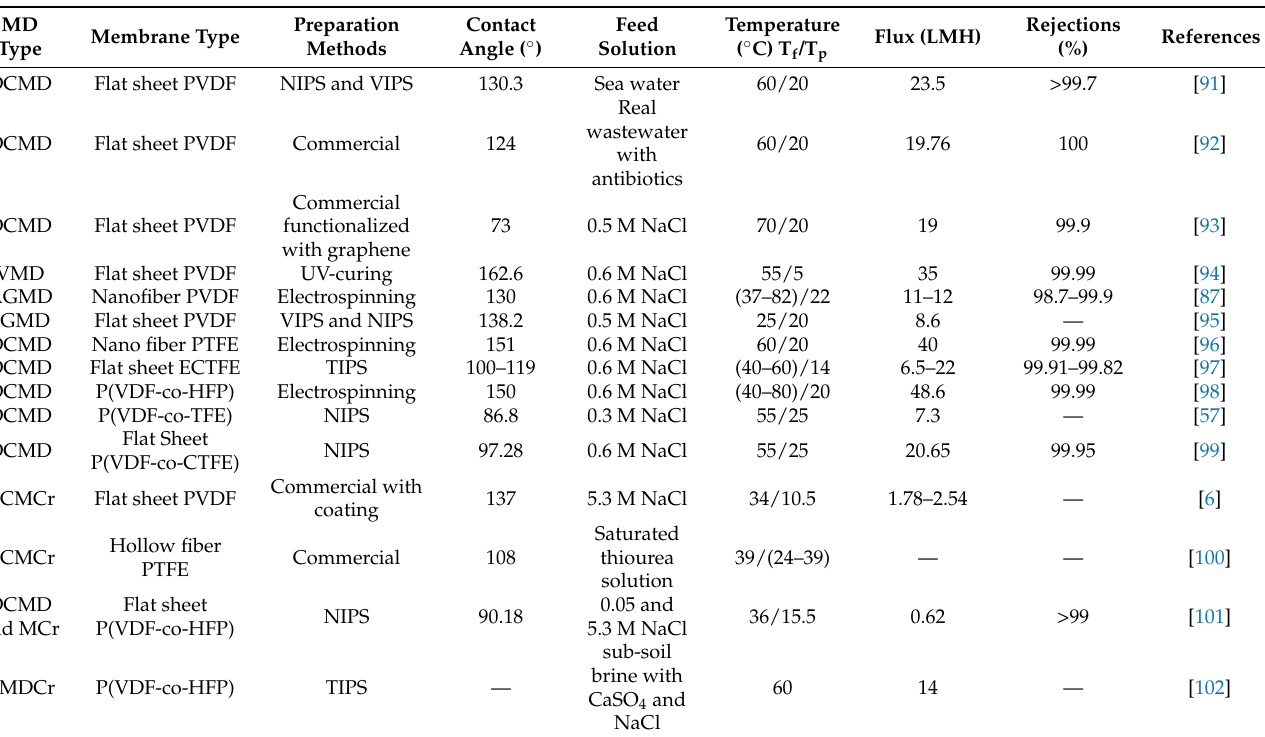
Table 4. Main applications of fluoropolymeric membranes in MD and MCr in recent years.